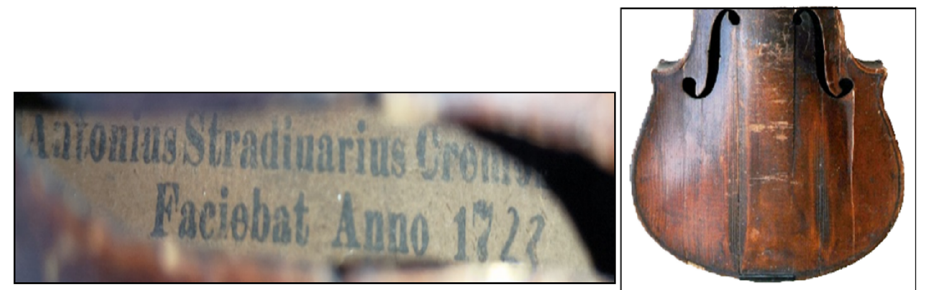
Figure 2. The inscriptions (label with dating, authorship and ownership) and the image with extended annual rings used for dendrochronological analysis.